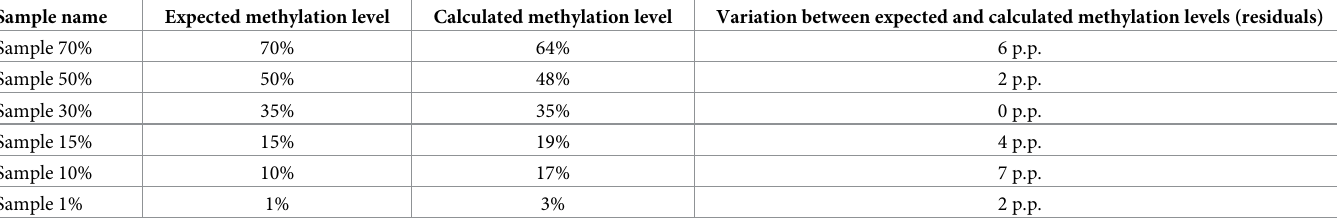
Table 1. The methylation levels calculated for each of the independent mixes used in the experiment.